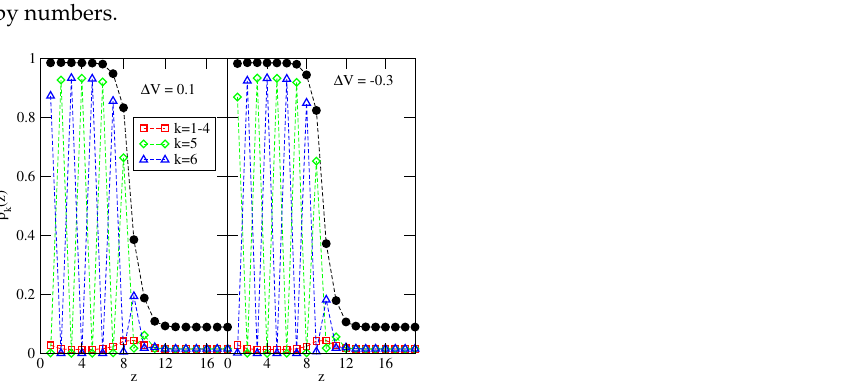
Figure 12. The local density profiles ρ k ( z ) for the systems with u BB = − 0.8, u AB = 0, ¯ V = − 0.8, for two different values of ∆ V equal to 0.1 (left panel) and − 0.3 (right panel). All profiles were recorded at T = 0.56 and µ = − 1.69. The filled circles mark the profiles of ρ ( z ) .